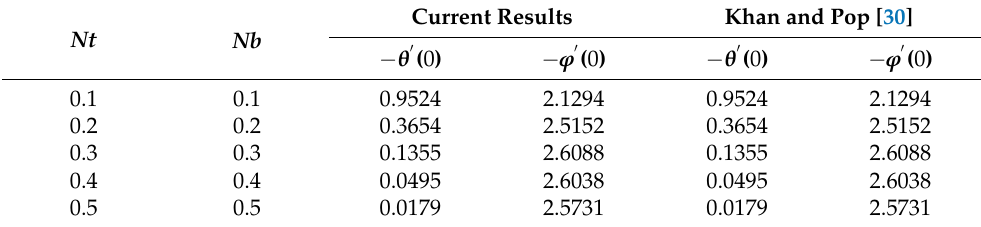
Table 1. Comparison of the reduced Nusselt number − θ (cid:48) ( 0 ) and the reduced Sherwood number, − ϕ (cid:48) ( 0 ) when M , K , m , λ , δ , η = 0, Pr , Le = 0.